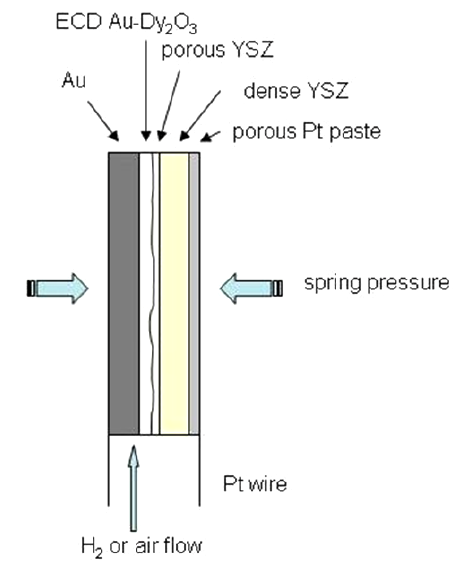
Figure 4. Schematic diagram of measurement apparatus employed for EIS